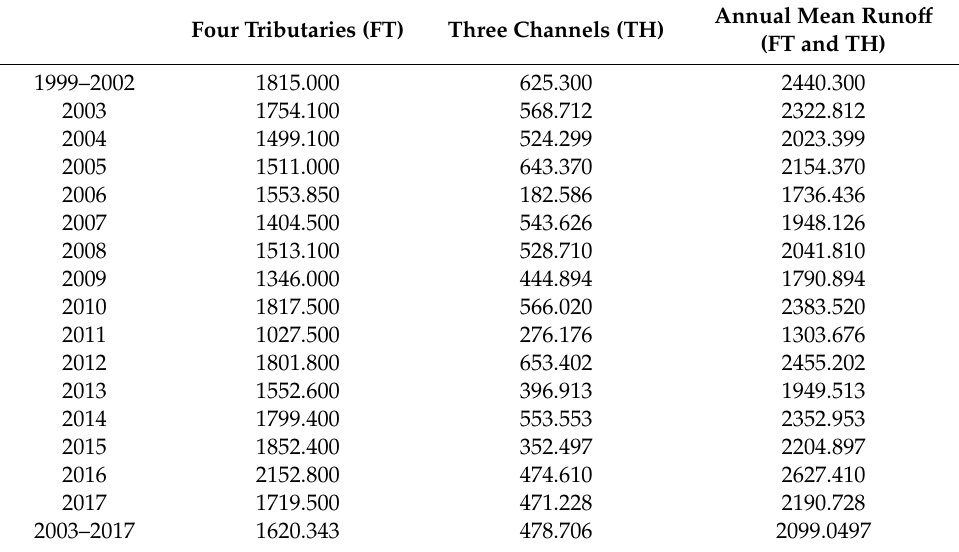
Table 4. Variations in annual mean runo ff in Dongting Lake (10 8 m 3